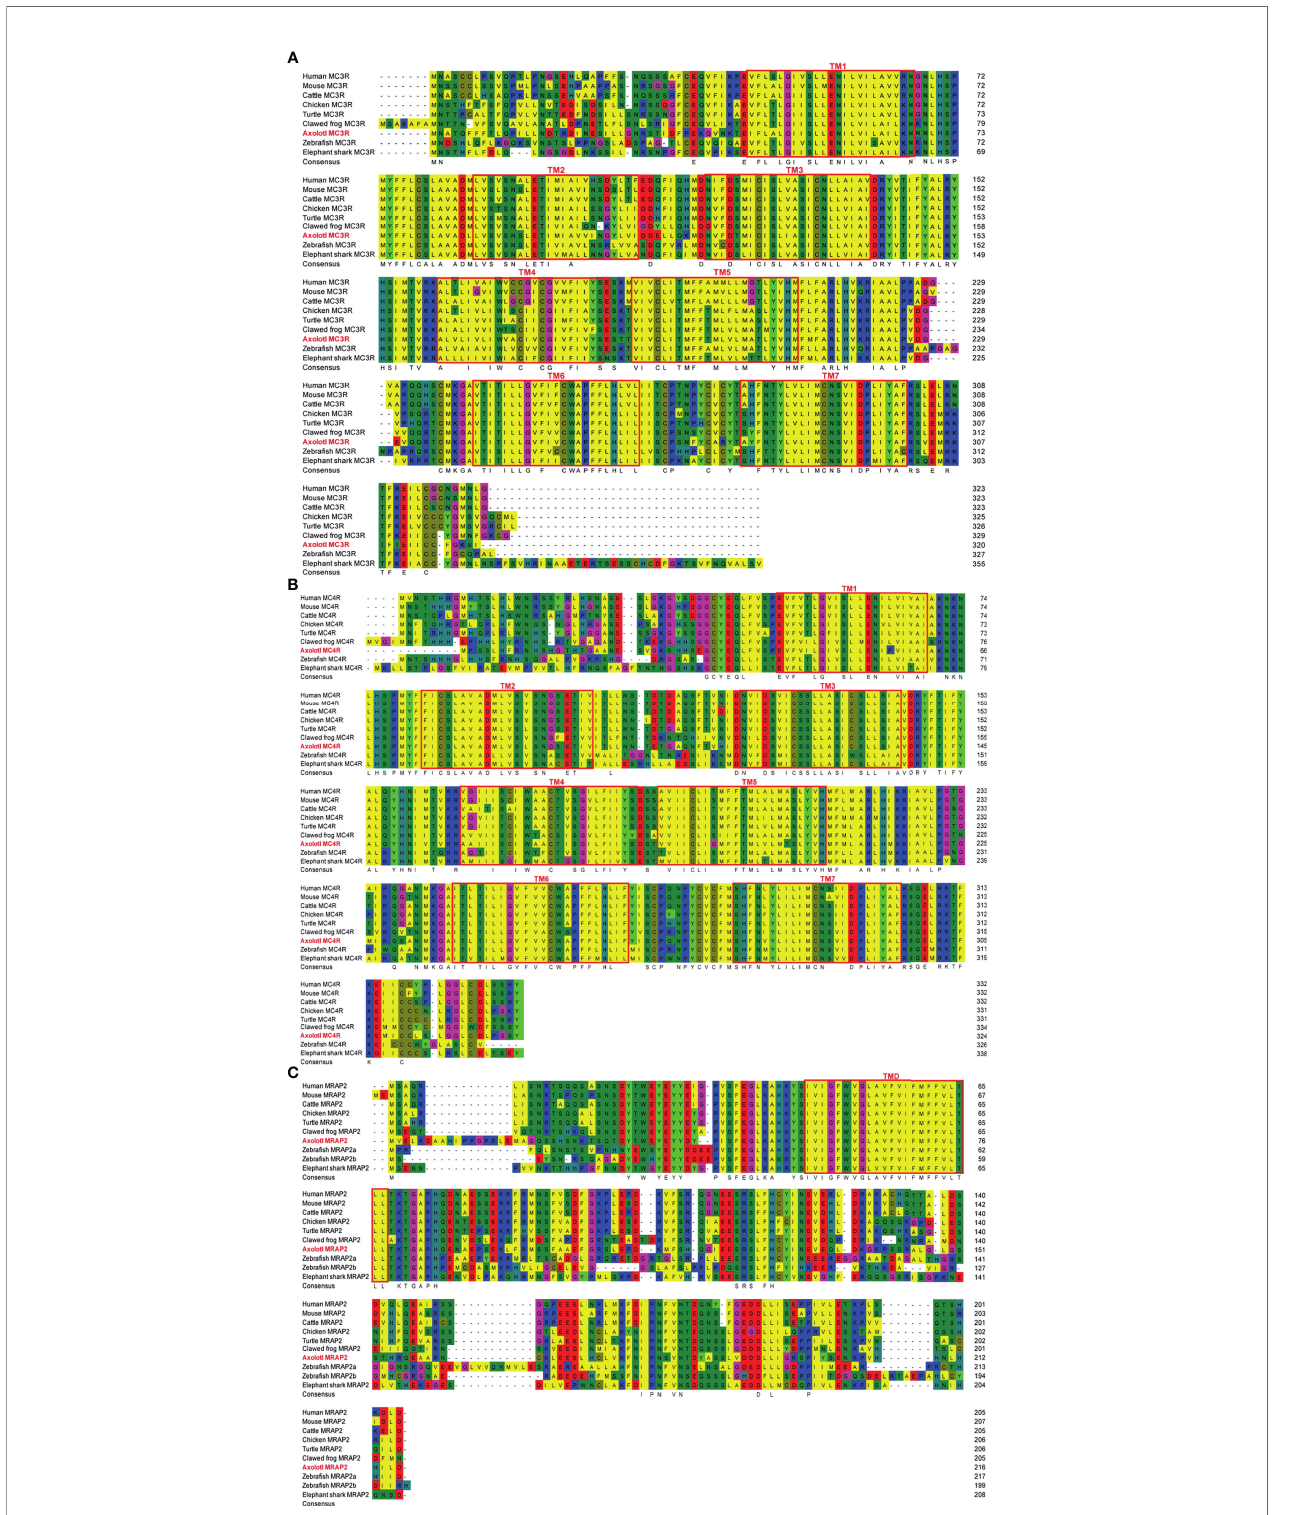
FIGURE 1 | Sequence alignments of multiple MC3R, MC4R, and MRAP2 proteins. (A) Sequence alignment of multiple MC3R proteins. (B) Sequence alignment of multiple MC4R proteins. (C) Sequence alignment of multiple MRAP2 proteins. The transmembrane (TM) regions in the amMC3R and amMC4R are represented by red box and are numbered 1 – 7. The red box marks the transmembrane domains (TM) in the